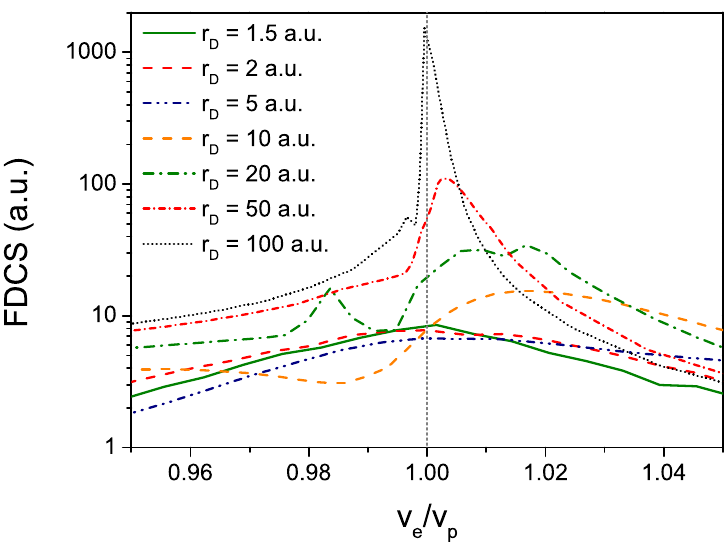
Figure 7. The Born-3DW fully differential cross section for forward emission in the scattering plane for the positron impact as a function of the ratio between the electron velocity and the projectile velocity v e / v P . The projectile scattering angle is set at 0 ◦ . The EEC peak position is indicated by a vertical dashed line. Cross sections are shown for different r D